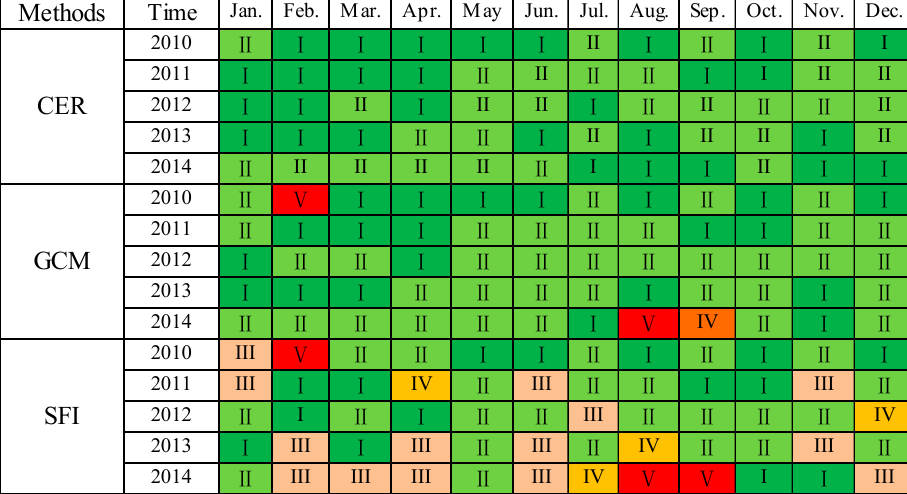
Figure 5. Comparison of water quality grades using various assessment methods. CER: comprehensive evaluation result; GCM: game theory-based cloud model; SFI: single factor index method.